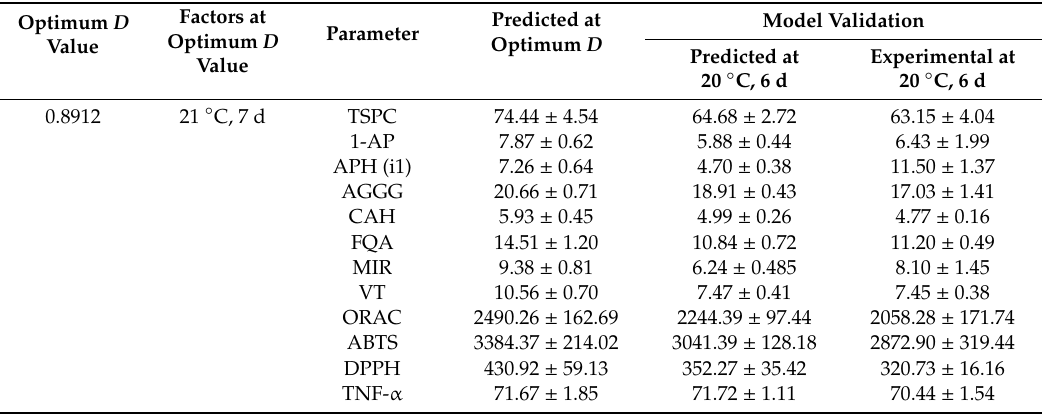
Table 4. Combination of germination factors and predicted values at optimum desirability (D) for phenolic content, antioxidant and anti-inflammatory